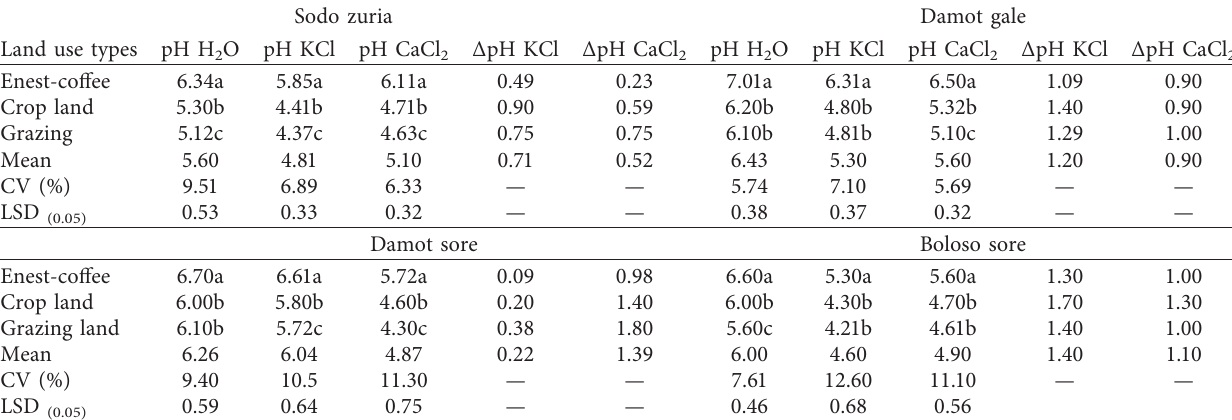
Table 3: Mean values of soil pH ( n � 108) and change of soil pH across different locations and land use types of study areas. Sodo zuria Damot